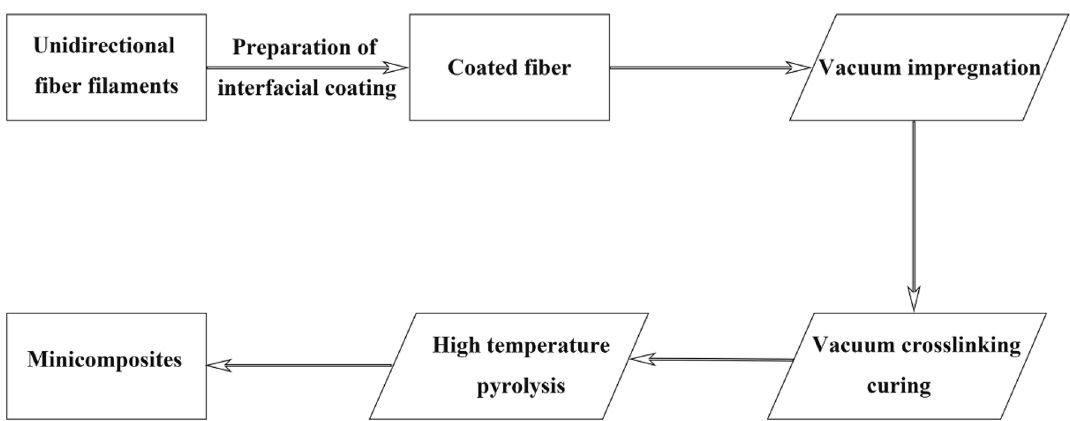
Figure 2. Preparation flow chart of SiC f /SiC